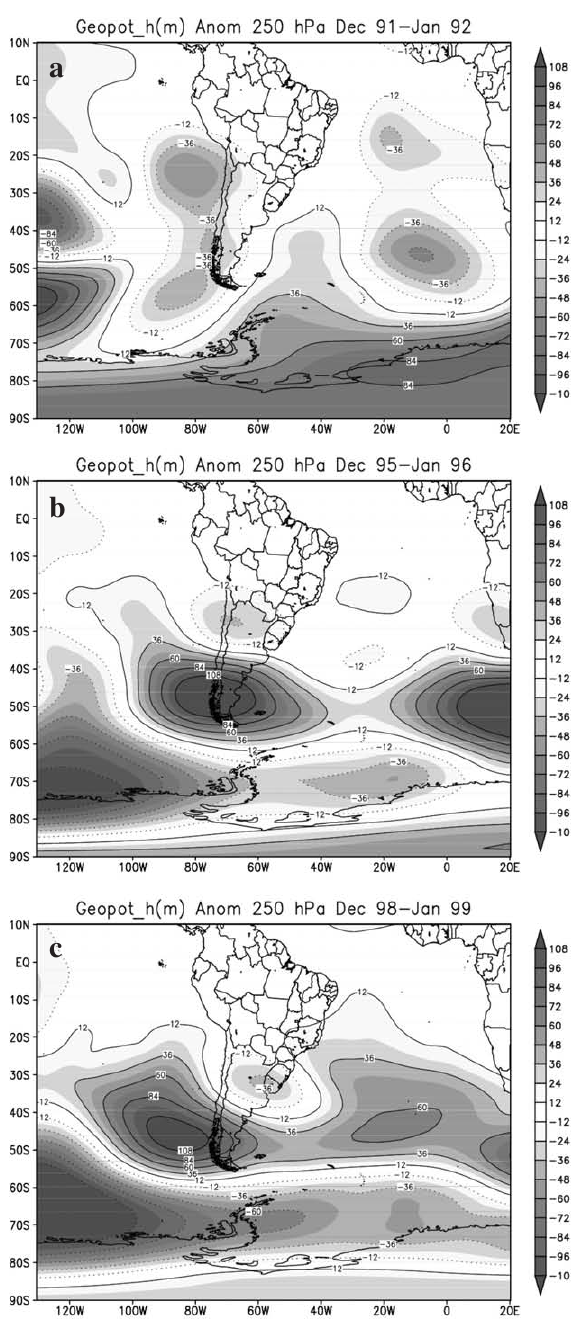
Fig . 8. – Anomaly fields for the case studies of: a) geopotential height (m) December 1991 and January 1992; b) geopotential height (m) December 1995 and January 1996; c) geopotential height (m) December 1998 and January 1999. Dashed lines are negative anomaly values and continuous lines are positive anomaly